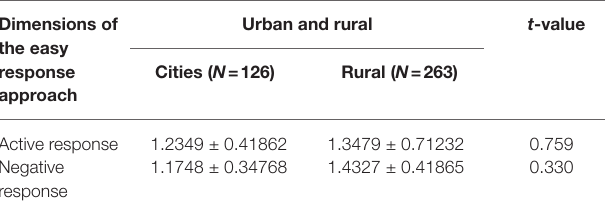
TABLE 2 | Analysis of the differences in coping styles between university students on the urban and rural dimensions. Dimensions of the easy